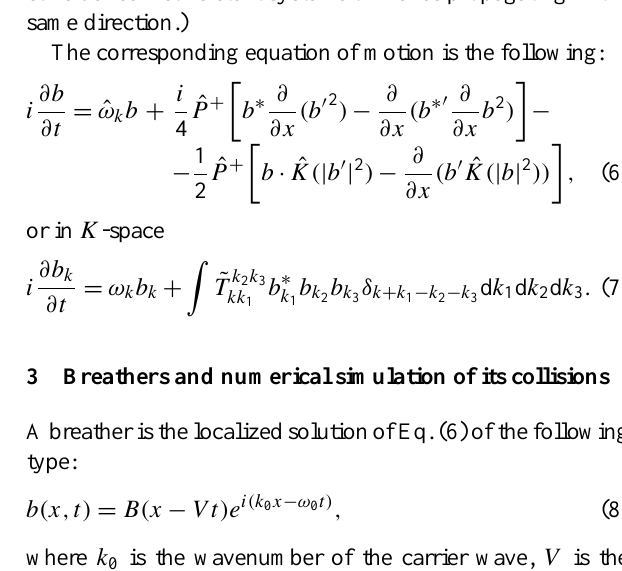
Fourier spectrum of b ( x ). Modulus of b ( x ) coincides with the